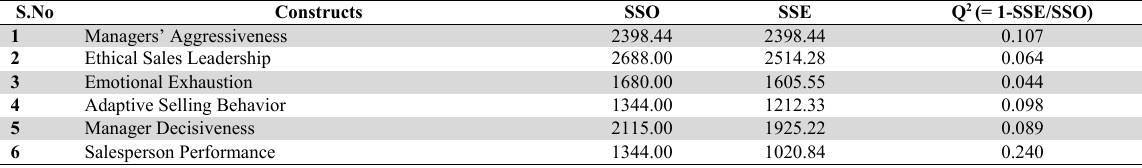
Blindfolding statistics for predictive relevance (Q 2 ) for the general